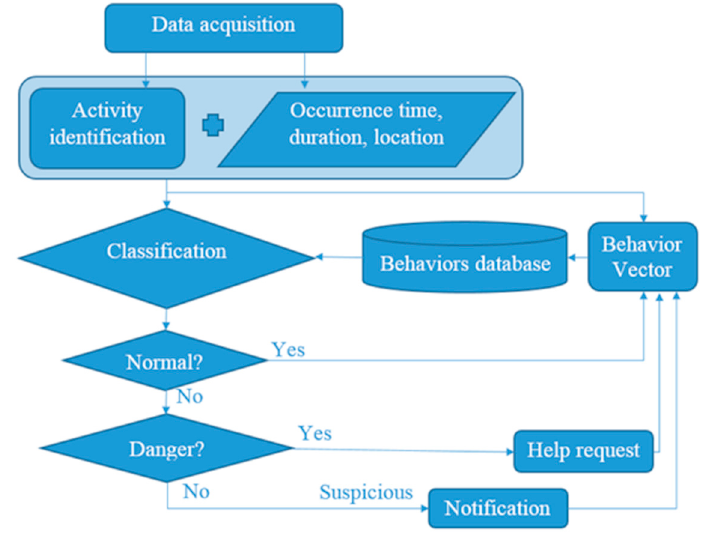
Figure 5. Behavior classification scheme.